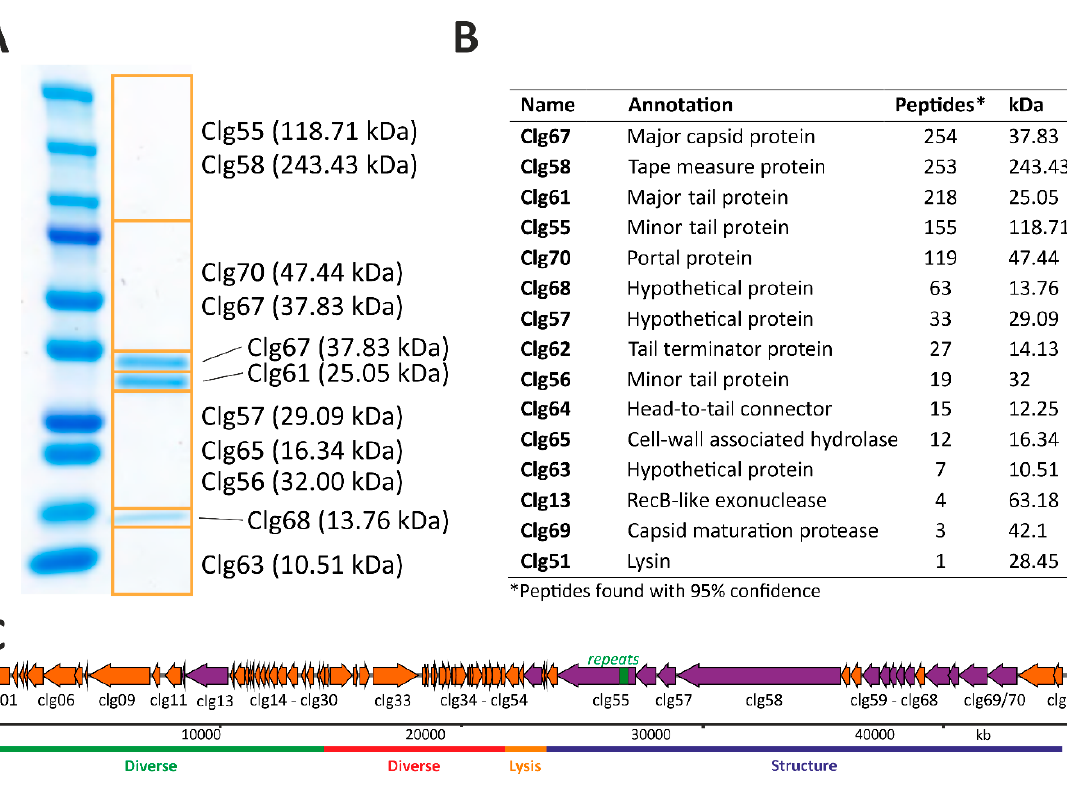
Figure 5. Analysis of the structural proteins of CL31 using SDS-PAGE and mass spectrometry. ( A ) SDS-PAGE of CL31 phage particles purified with CsCl-gradient centrifugation. ( B ) LC/MS analysis of whole phage particles. ( C ) Comprehensive scheme of all proteins found (purple) in ( A , B ).